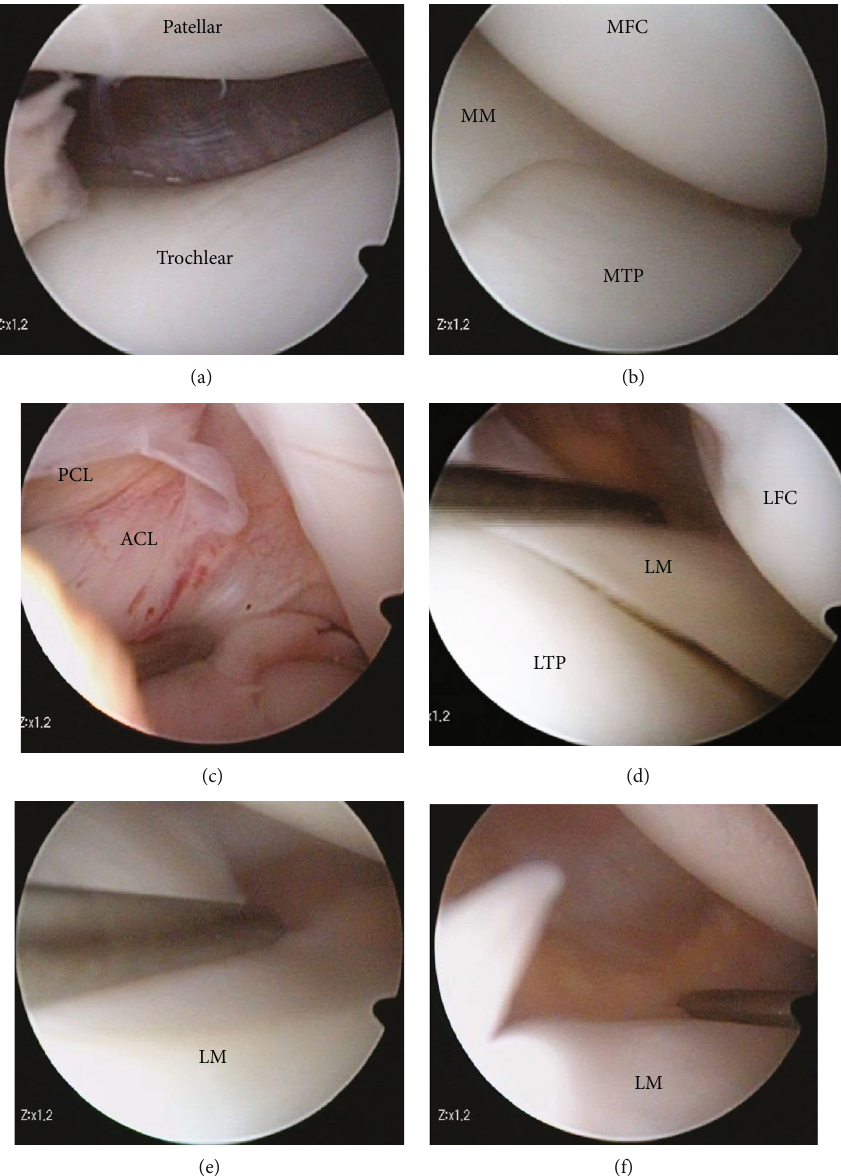
Figure 3: Arthroscopic fi ndings. (a) No cartilage injury at the patellofemoral joint; (b) no meniscus or cartilage injury in the medial compartment; (c) ACL and PCL were intact; (d – f) no posterior lateral meniscus or cartilage injury. Figures 2(d) and 2(e) were viewed from the anterolateral portal. Figure 2(f) was viewed from the anteromedial portal. MM: medial meniscus; MFC: medial femoral condyle; MTP: medial tibial plateau; ACL: anterior cruciate ligament; PCL: posterior cruciate ligament; LM: lateral meniscus; LFC: lateral femoral condyle; LTP: lateral tibial